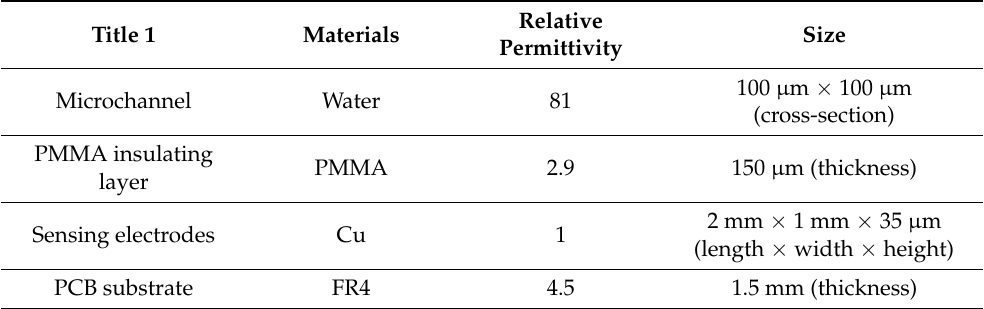
Table 1. Detailed information of the simulated C4D